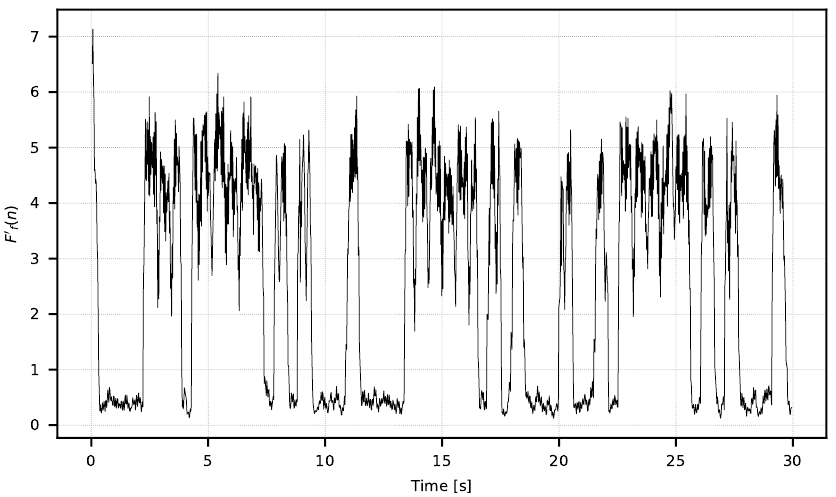
Figure 8. Signal F (cid:48) p , which is the power of the filtered signal F (cid:48) .